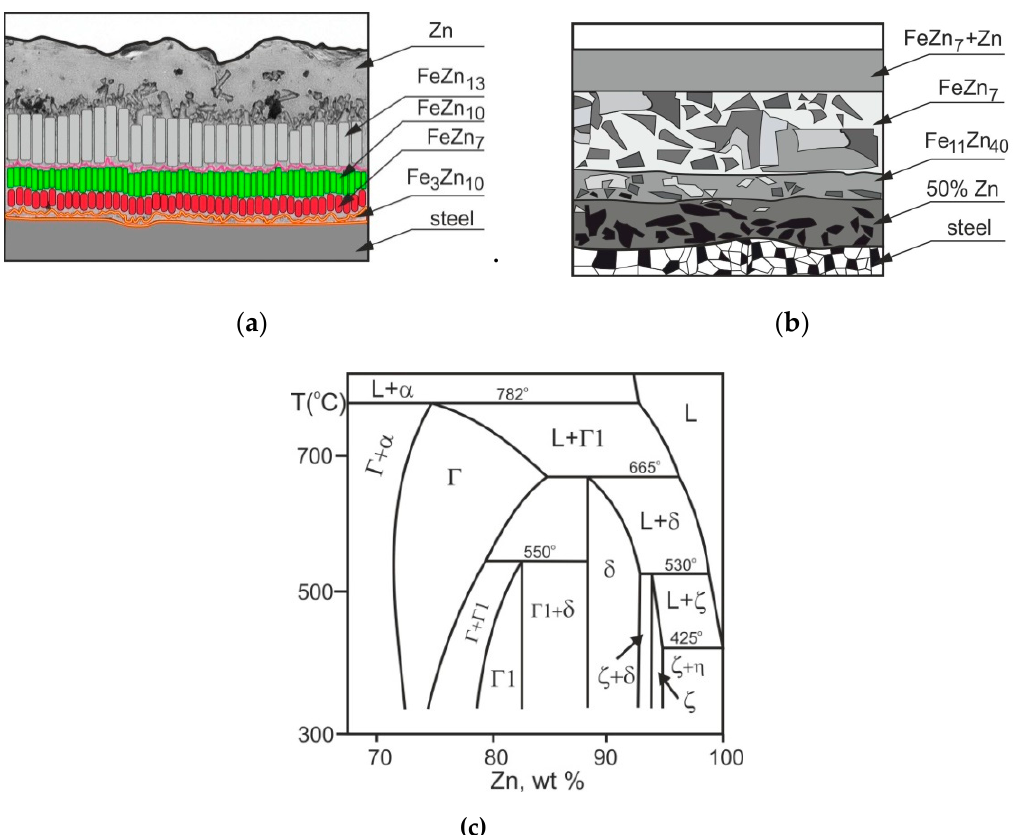
Figure 1. The microstructure of the zinc galvanizing coatings in relation to the Fe-Zn system; ( a )—hot-dip [22], ( b )—thermal diffusion [23], ( c )—Fe-Zn equilibrium system [24,25] .